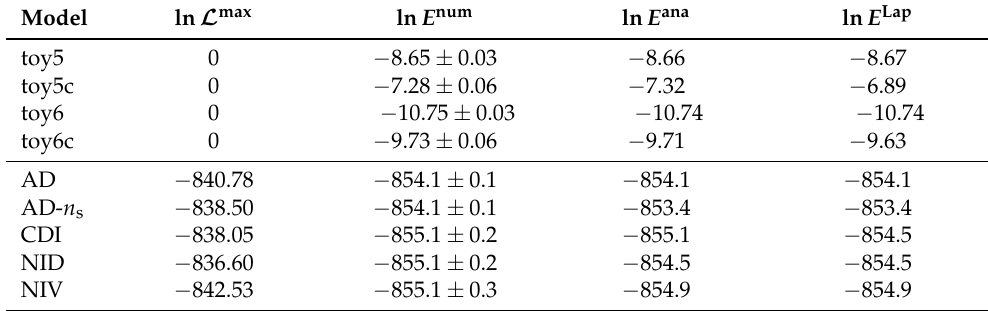
Table 3. The different models, both toy and real, with their maximum likelihoods and